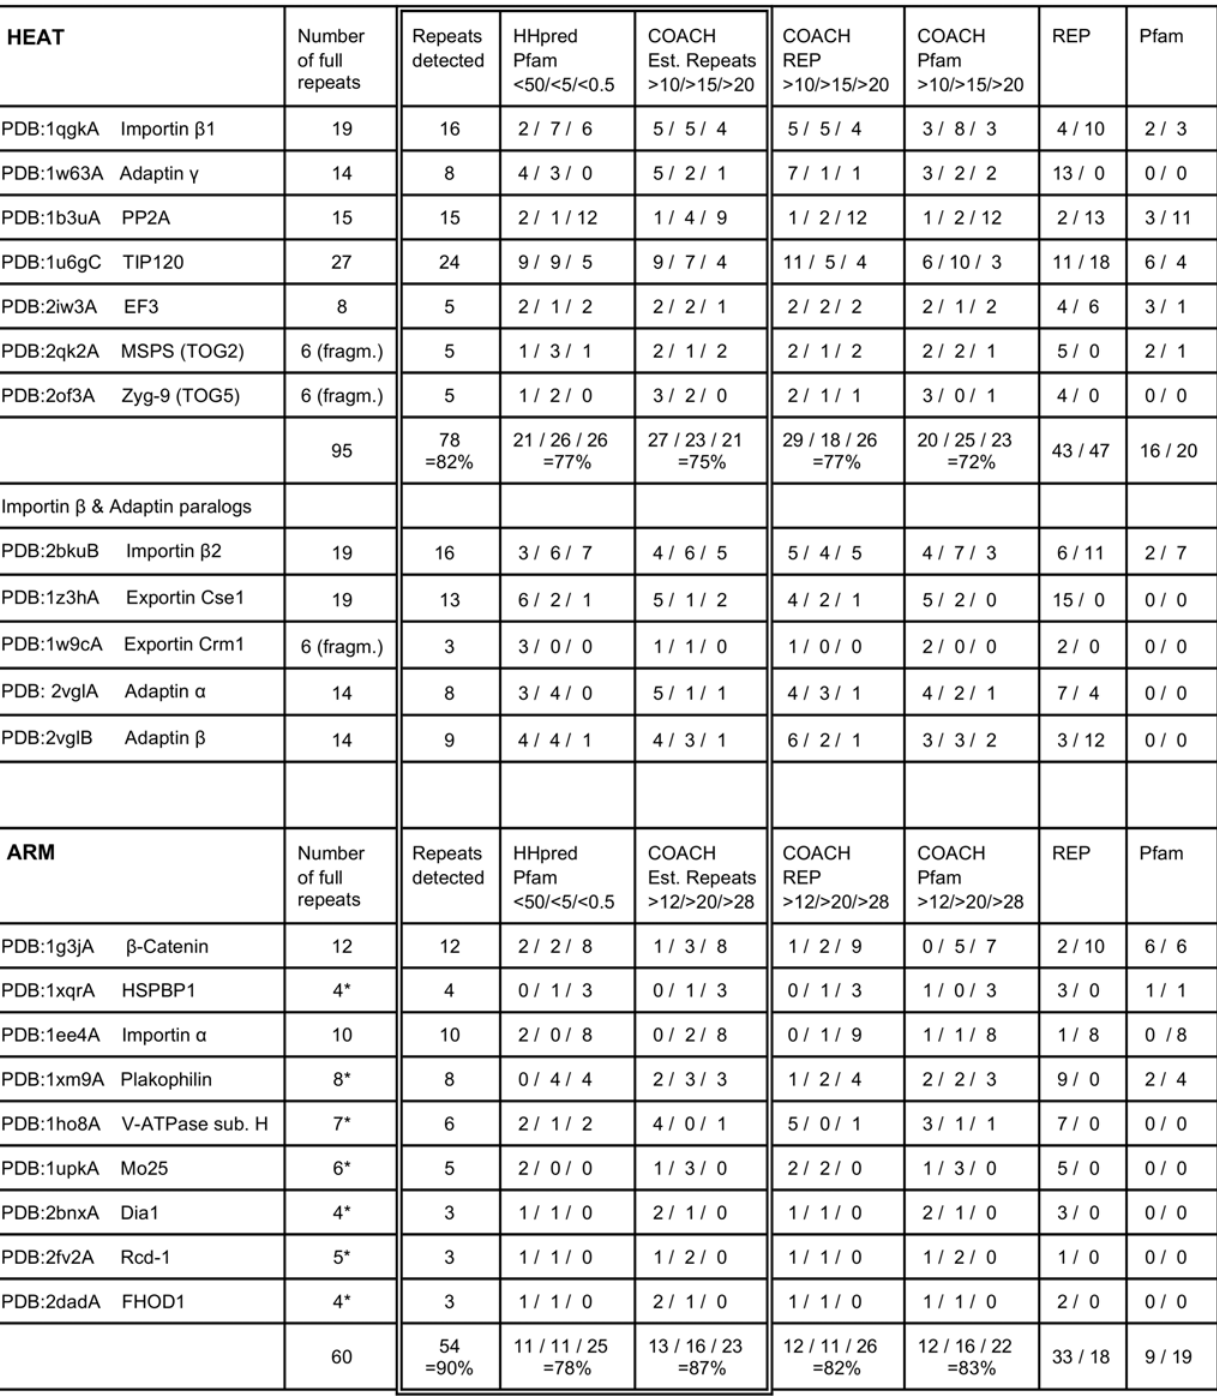
Figure 3. Detection of individual HEAT and ARM repeats in proteins with known structures. The number of full repeats was taken from the structures as deposited in PDB and/or associated publications; asterisks mark ARM proteins with truncated two-helix repeats at the N-terminus which were not included in the analysis. Repeats detected are those with matches better than the lowest threshold by HHpred ( i.e. E-value , 50) and/ or COACH(Established Repeats; score . 10 for HEAT and . 12 for ARM). HHpred and COACH results were grouped in four classes as described in the text and the numbers of repeats falling in the three better scoring confidence classes are given here. REP and Pfam results are for subsignificant/ significant matches as returned by the